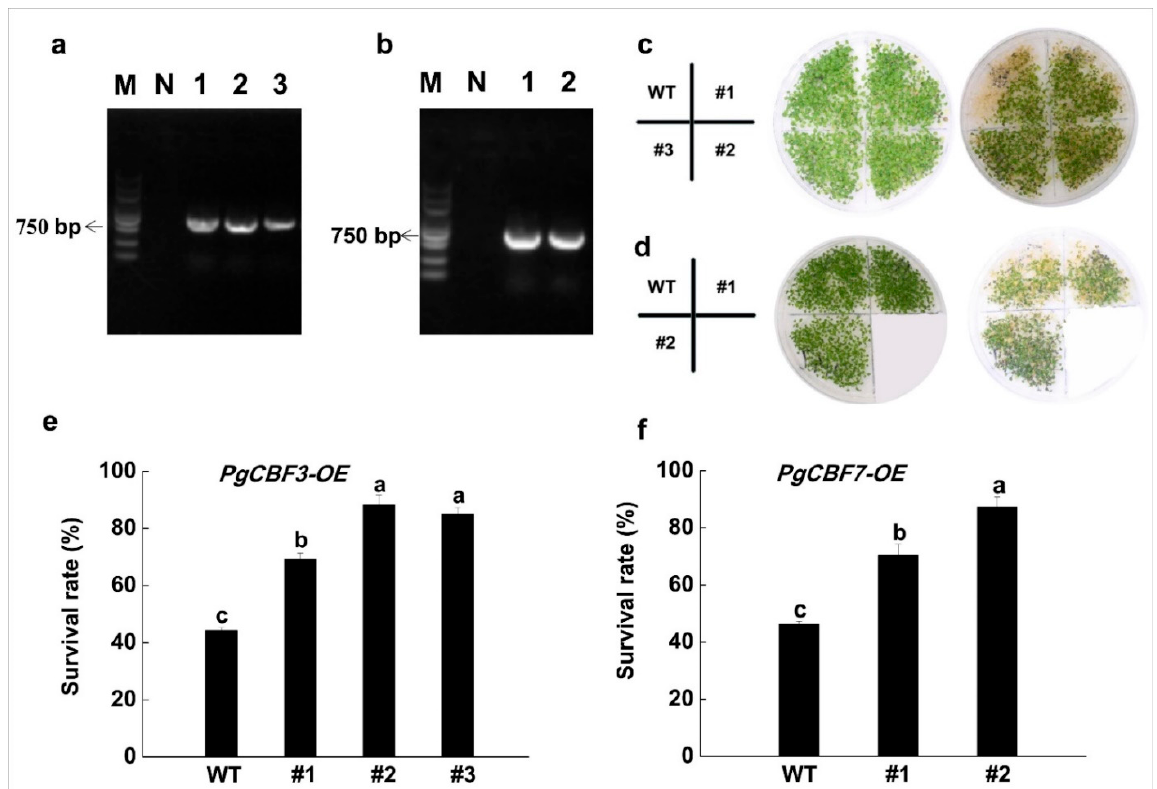
Figure 5. Identification of PgCBF3 and PgCBF7 transgenic Arabidopsis lines and phenotype and survival rate of PgCBF3 and PgCBF7 transgenic Arabidopsis lines at − 2 °C. Identification of transgenic Arabidopsis lines of PgCBF3 ( a ) and PgCBF7 ( b ), N represents a negative control using sterilized water; phenotype of transgenic Arabidopsis lines of PgCBF3 ( c ) and PgCBF7 ( d ) after − 2 °C treatment; survival rate of transgenic Arabidopsis lines of PgCBF3 ( e ) and PgCBF7 ( f ) after − 2 °C. Different letters present significant differences ( p < 0.05).